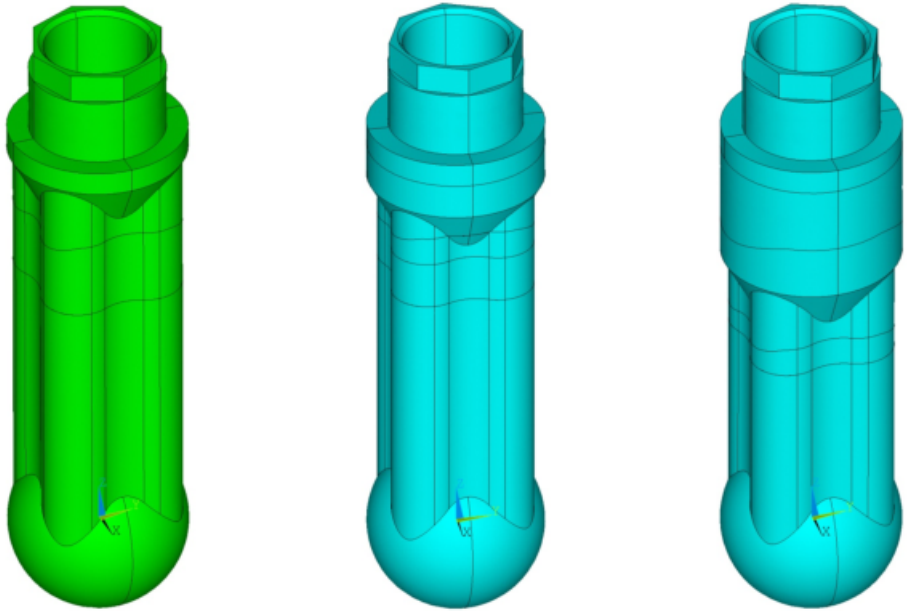
Figure 4. Optimization of the geometrical shape in the upper cylindrical part: reference model 0001A (cyl. width